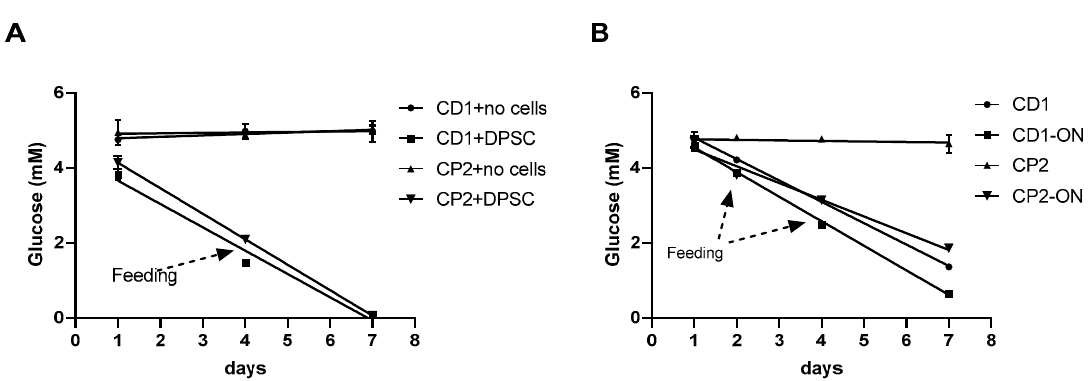
Figure 11. Glucose utilization by DPSCs cultivated with Cytodex 1 (CD1) or Cytopore 2 (CP2) in 96-well plates under static conditions and in shake flasks under dynamic conditions for 7 days. ( A ) Static conditions in 96-well plates. Microcarriers were cultured in static conditions without DPSCs (CD1, CP2) or with DPSCs (CD1+DPSC, CP2+DPSC). The medium was partially changed at day 4. ( B ) Dynamic cultivation in shake flasks. Flasks were either immediately shaken (CD1, CP2 or were left) in the incubator overnight before shaking started (CD1-ON and CP2-ON). The medium was partially supplemented at day 2 and then partially changed at day 4. Values are means ± SEM ( n =